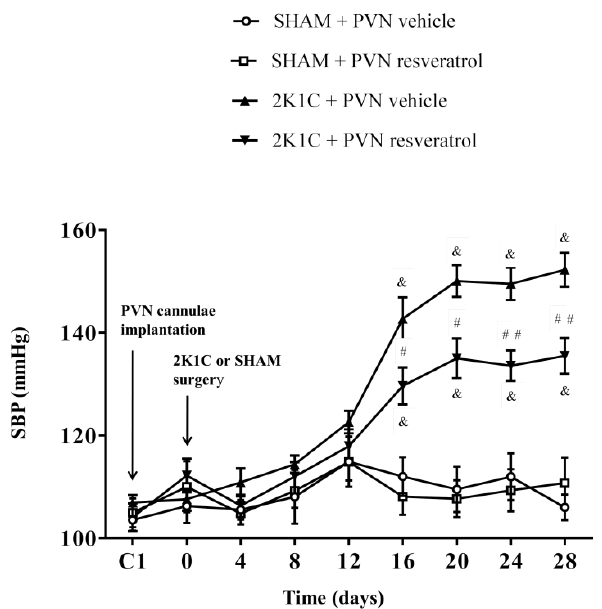
Figure 1. The effects of resveratrol on SBP. Values are the mean ± SEM. & p < 0.001 vs. SHAM groups; # p < 0.05 or ## p < 0.01, relatively to 2K1C + PVN vehicle, n = 5.